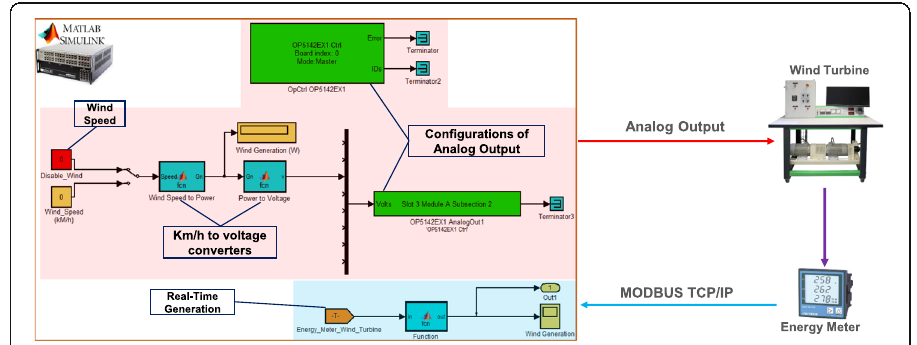
Fig. 4 Simulink HIL models for wind generation of prosumer in BUS